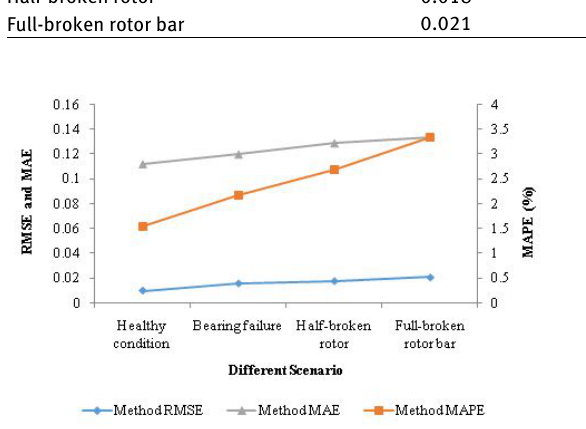
Figure 11: Parameters obtained for four different scenarios parameters like SNR and SSIM are also checked to check the performance of the technique as shown in Table 4.